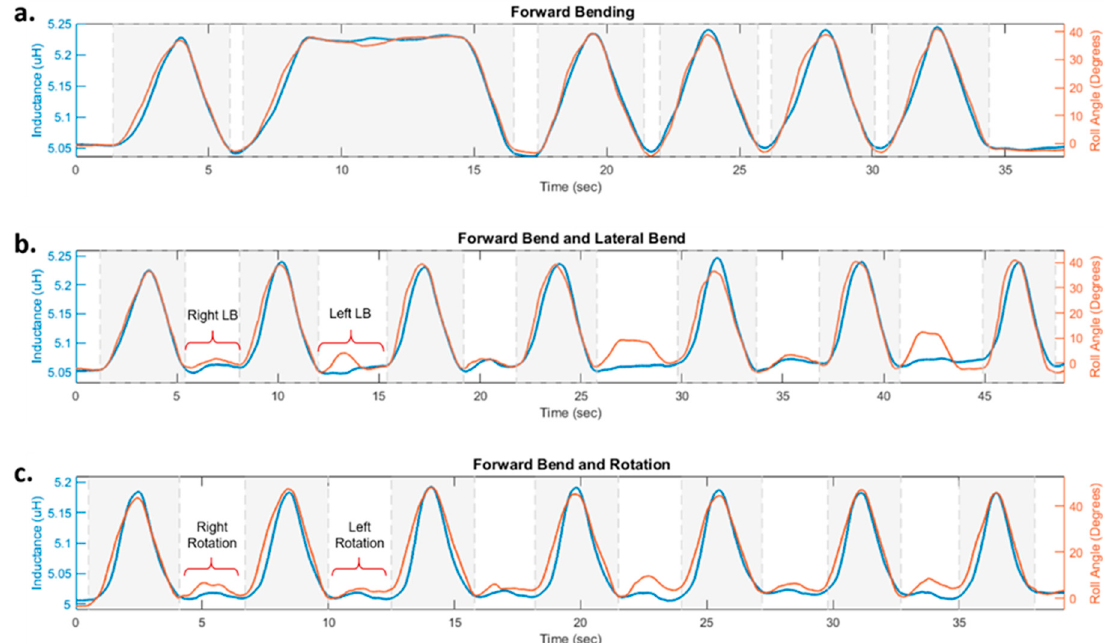
Figure 7. Inductance values (µH) recorded from the designed sensor and actual forward bending angles (degrees) recorded by inertial measurement units (IMUs) during the considered trunk movements: ( a ) forward bending; ( b ) forward and lateral bending; ( c ) forward bending and trunk rotation. In each case, the periods of forward bending are highlighted in grey shade.